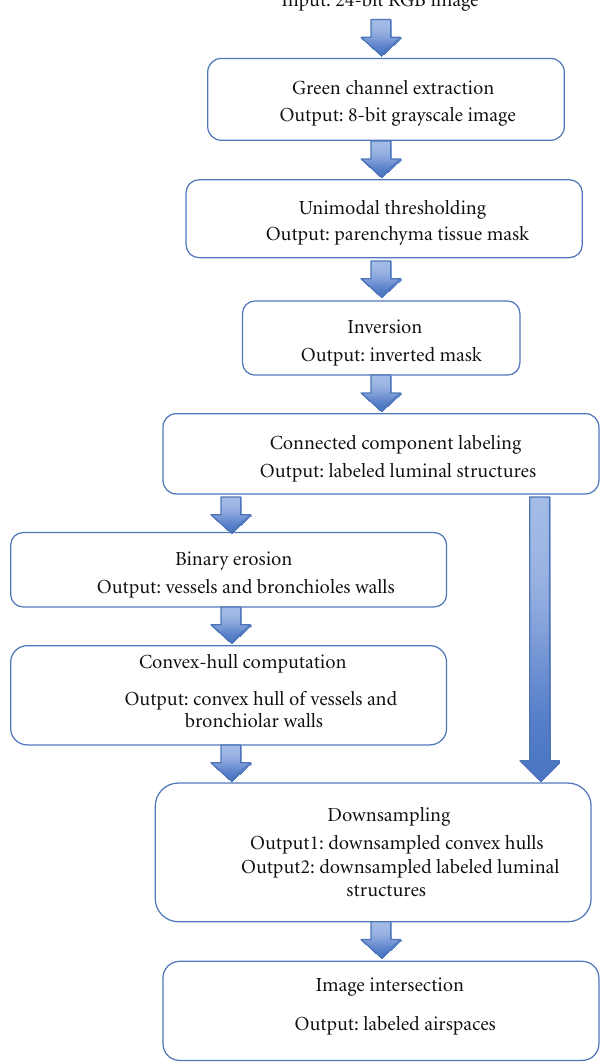
Figure 4: Flowchart of the airspace segmentation and labeling approach discarding the vessels and alveoli.